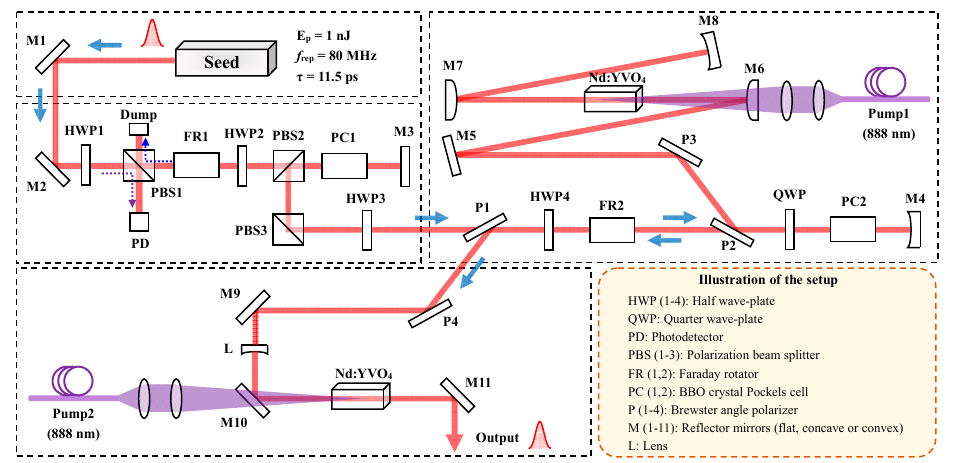
Figure 1. Diagram of the non-leakage 100-kHz Nd:YVO 4 picosecond regenerative amplifier. The inset is the illustration of the setup.